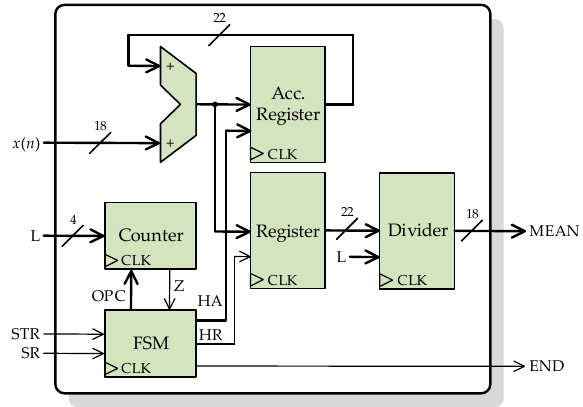
Figure 9. Architecture of the digital structure for computing the mean.